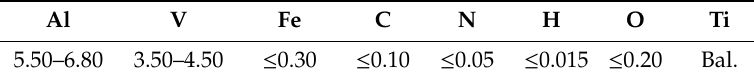
Table 1. Chemical compositions of base metal (wt.%).